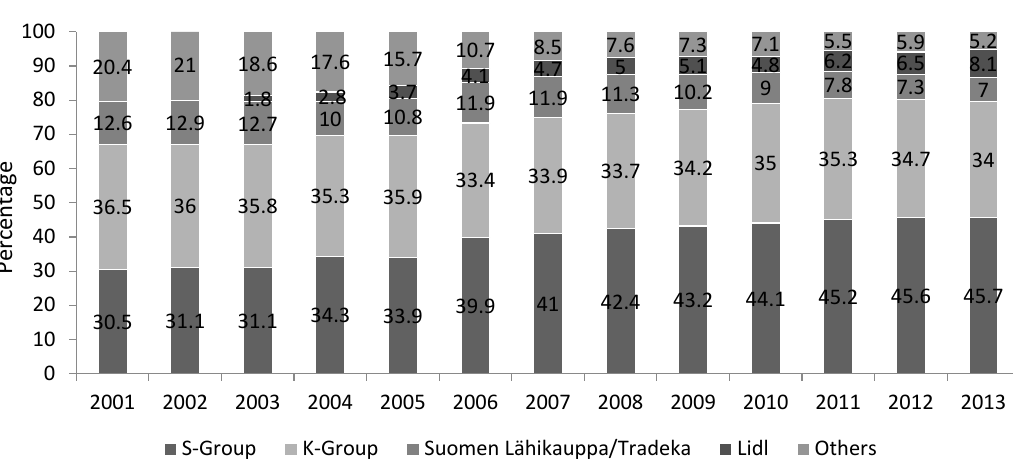
Fig. 1. Development of the market shares of Finnish grocery trade